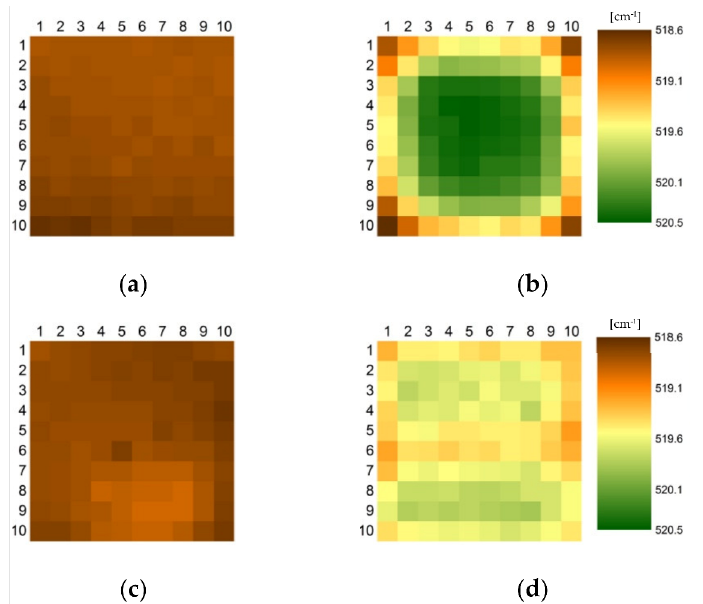
Figure 7. Raman-shift distribution at room temperature of the ( a ) Si_Unmounted chip, ( b ) A_AuSn, ( c ) A_AuSn_p, and ( d ) B_AuSn